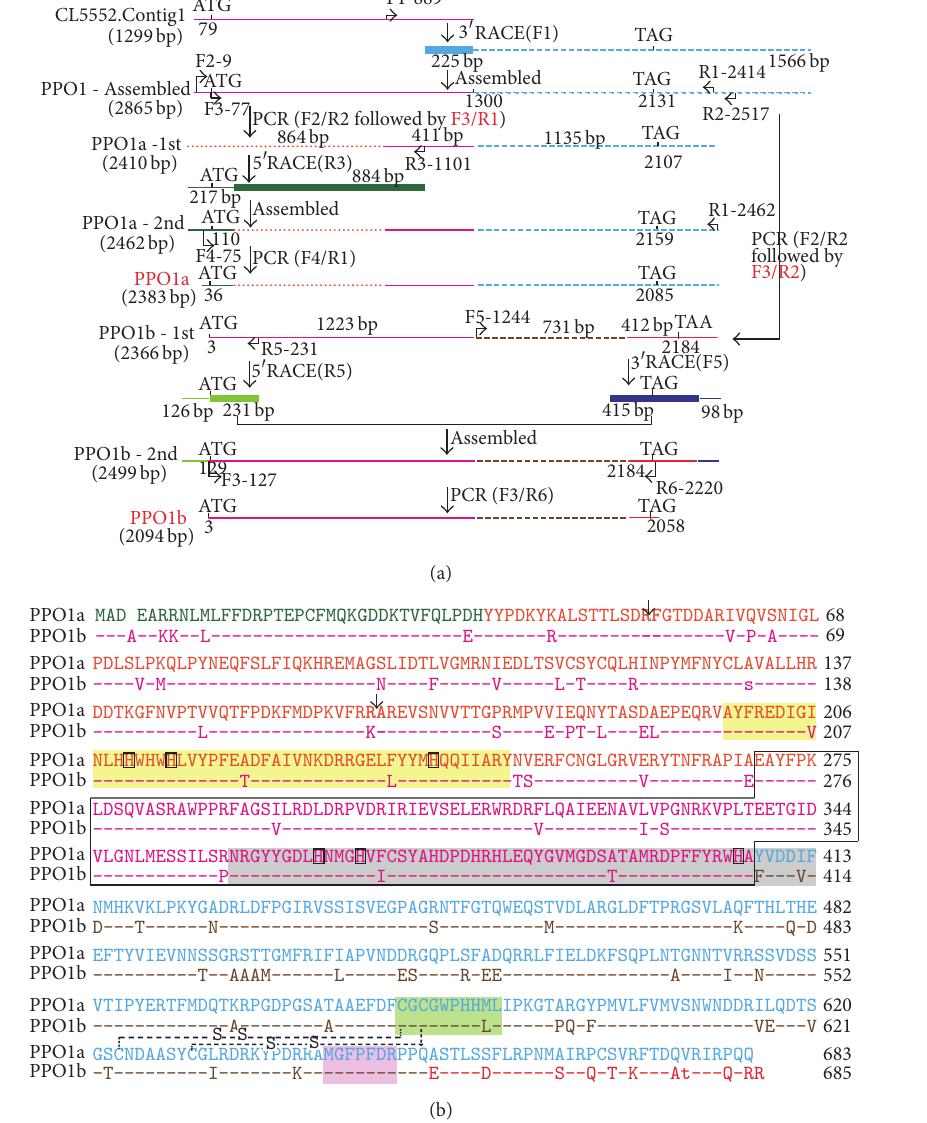
Figure 1: Cloning of OfPPO1a and OfPPO1b . (a) Schematic demonstration of the process for cloning full-length OfPPO1a (NCBI accession number: KX452359) and OfPPO1b (NCBI accession number: KX437622). The fragments with identical nucleotide sequences are illustrated in lines with the same color. The specific primers are labeled with the name followed by its position in the located fragment and indicated by the arrows above or below the lines. The predicted start codon and stop codon are indicated at the corresponding positions. (b) Comparisons and sequence analysis of deduced OfPPO1a and OfPPO1b. The deduced amino acid residues are shown in the same color scheme as in part (a). Identical residues in PPO1a and PPO1b are substituted by hyphens in PPO1b. Regions common in PPO1a and PPO1b are indicated by an irregular rectangle. The predicted proteolytic cleavage bonds were shown in red and marked with black arrow. The potential copper binding site A (CuA), copper binding site B (CuB), the putative thiol ester sites, and a conserved motif at the C-terminus were shaded in yellow, grey, green, and purple, respectively. The six histidine residues absolutely conserved within the CuA and CuB were in the square boxes. Two predicted disulfide linkages are represented by dashed